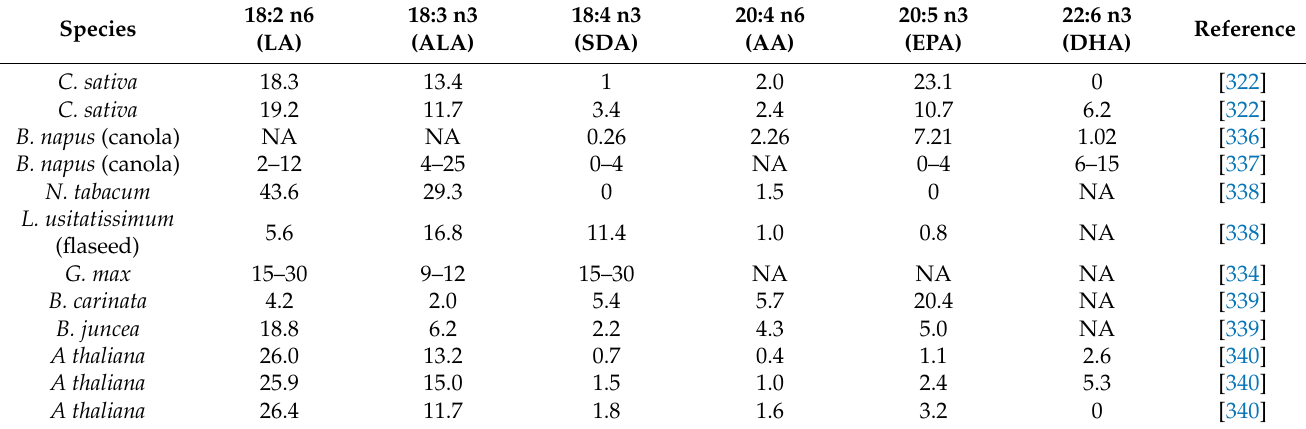
Table 4. Main characteristic of some GM plants 1